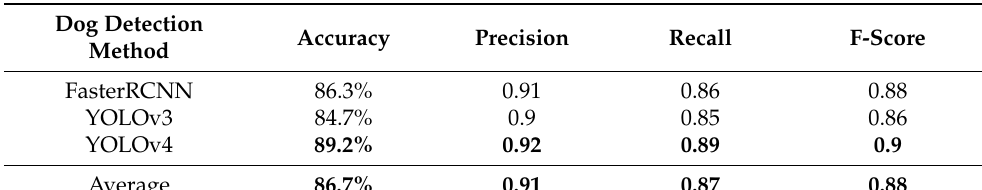
Table 5. Results of behavior recognition performance evaluation by dog detection methods using video data.